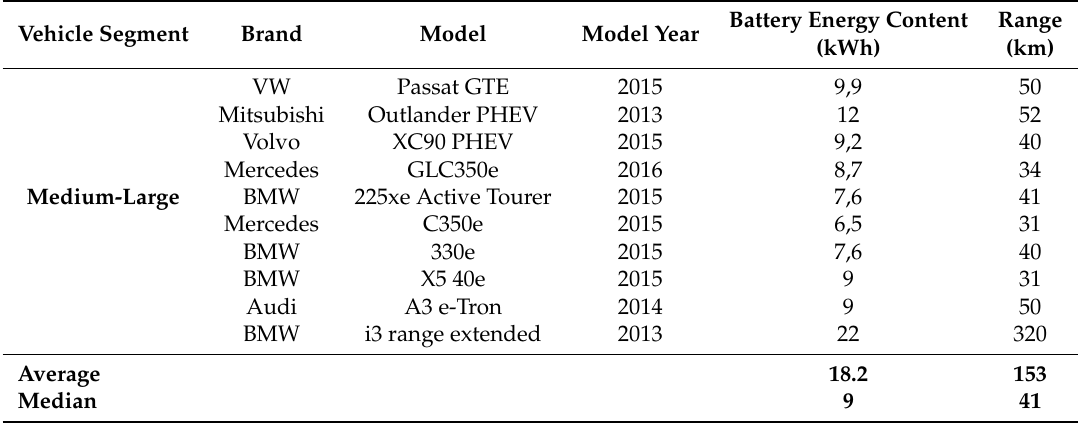
Table 2. Overview of most sold hybrid electric vehicles in 2016 in Europe (10 most popular). Vehicle